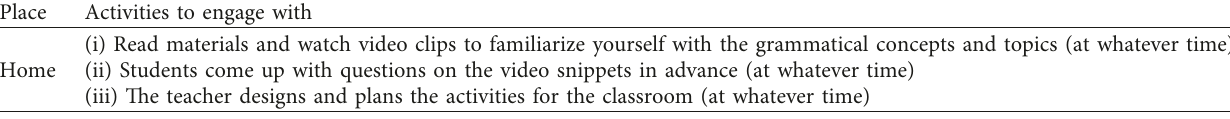
Table 4: Each lesson’s flipped learning